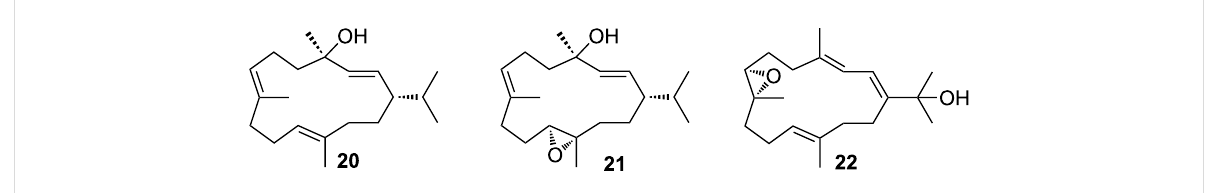
Figure 2: Structures of secondary metabolites from P. longicirrum as described by Coll et al. in 1985 [13].